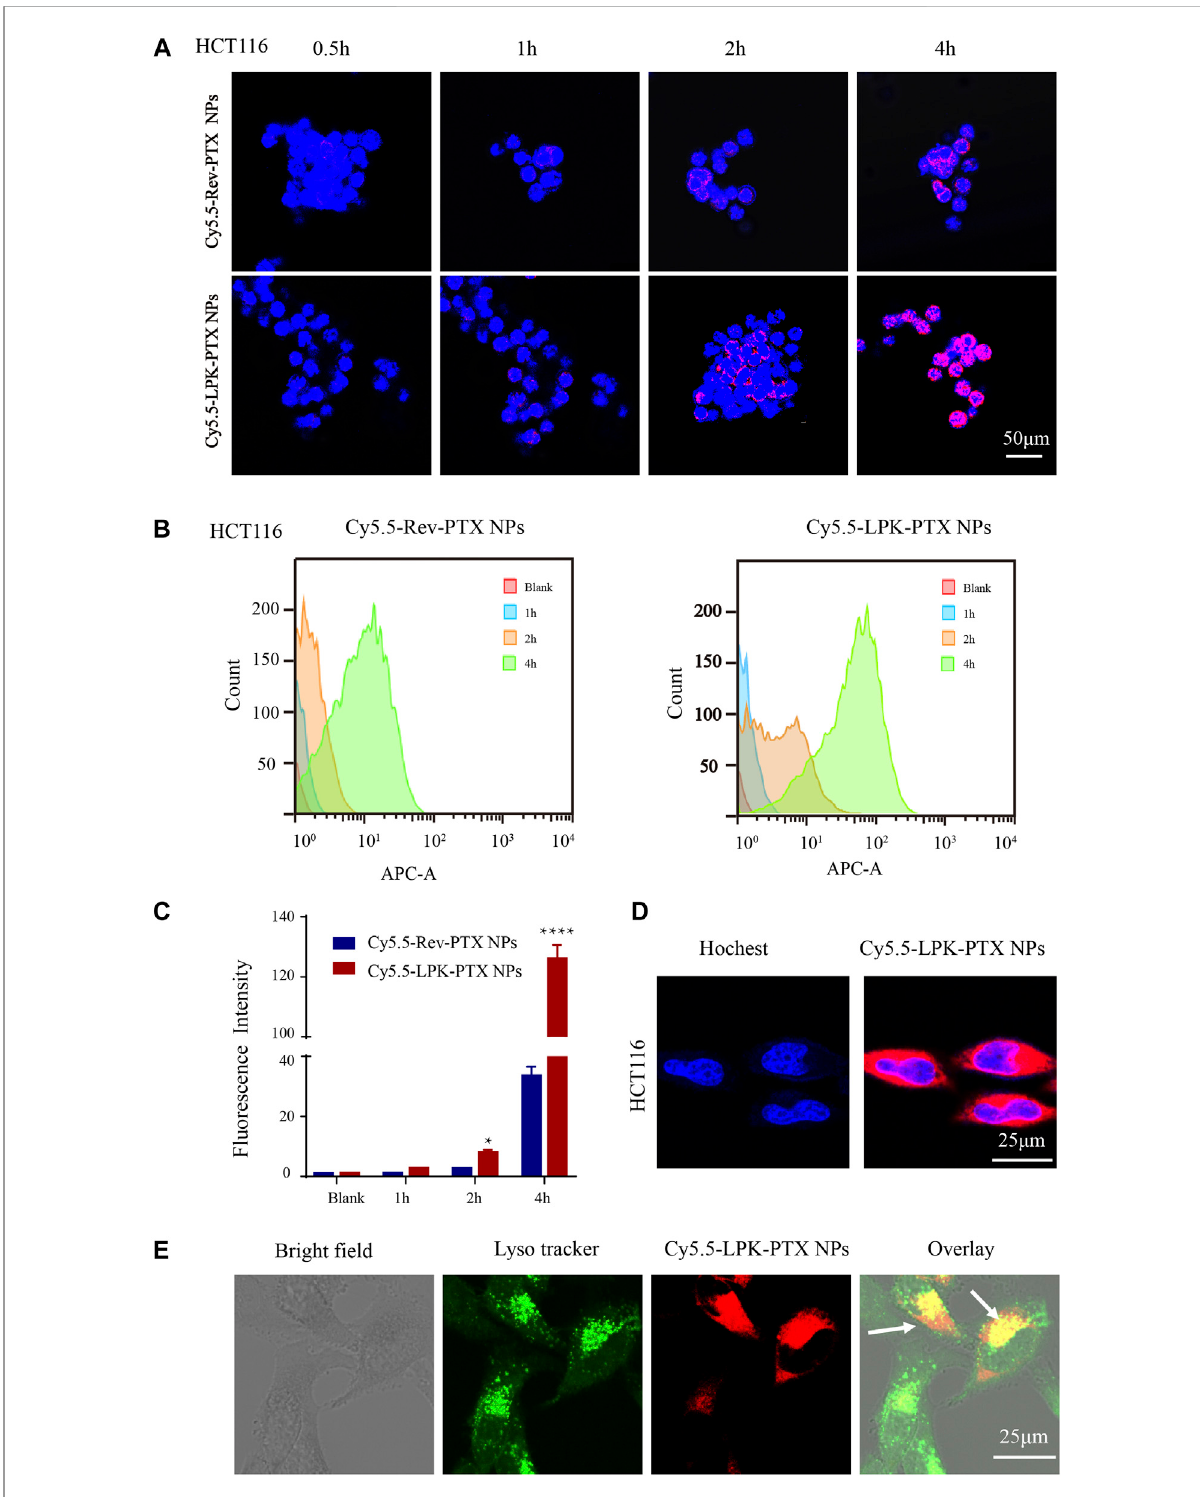
FIGURE 3 CellularuptakeofCy5.5-LPK-PTXNPs invitro . (A) Confocallaserscanningmicroscopy(CLSM)imagesofHCT116cellsincubatedwith20 μ g/ml Cy5.5-Rev-PTX NPs or Cy5.5-LPK-PTX NPs for 0.5, 1, 2, and 4 h, respectively. The fl uorescence intensity of Cy5.5-LPK-PTX NPs was much stronger than Cy5.5-Rev-PTX NPs at various times. (B, C) Cellular uptake of Cy5.5-Rev-PTX NPs or Cy5.5-LPK-PTX NPs in HCT116 cells after incubation for